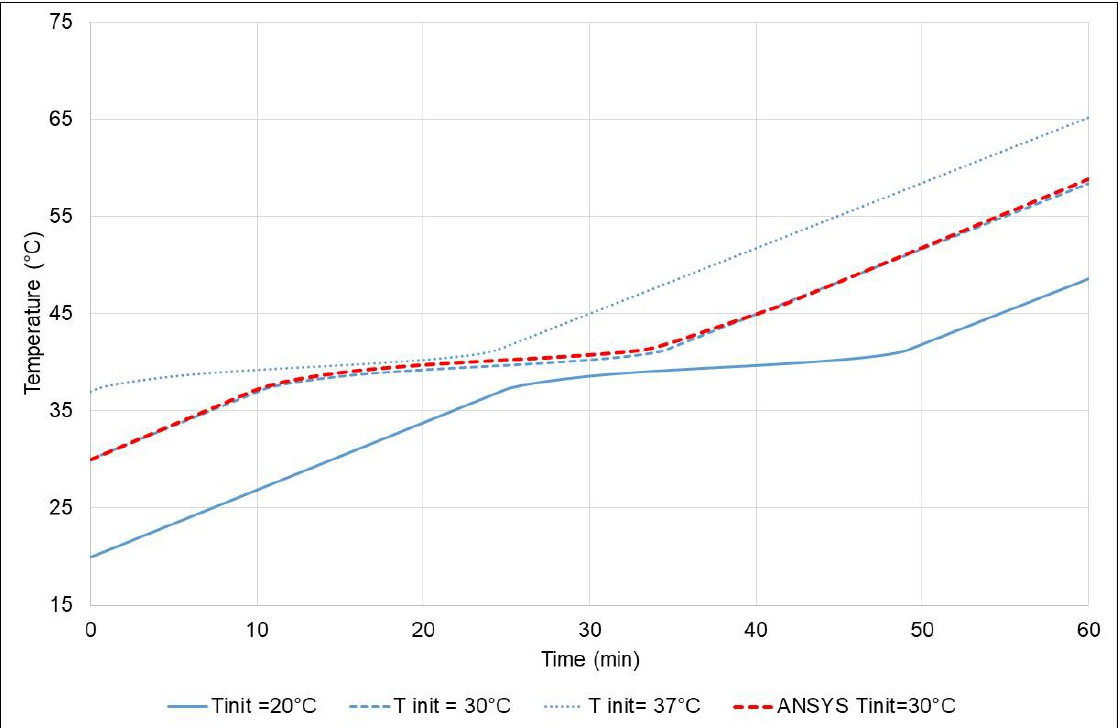
Figure 6. Calculated average temperature of battery HSS during a 1-C discharge for different initial temperatures of the pack.